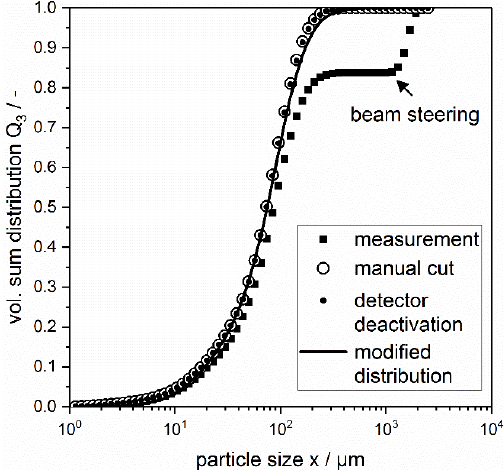
Figure 8. Comparison of beam-steering correction methods. Sum distributions of a measurement with low viscous medium ( µ = 0.12 Pa · s, p gas = 0.8 MPa). Uncorrected measurement (squares), correction by manual cutting (empty circles), correction by detector deactivation (filled circles), and correction by the new modification procedure described (line).